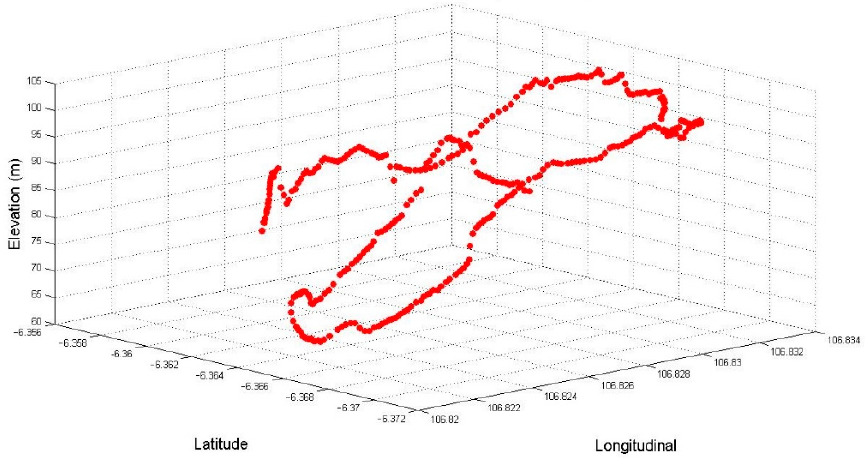
Figure 7. Vehicle coordinate vs. elevation.